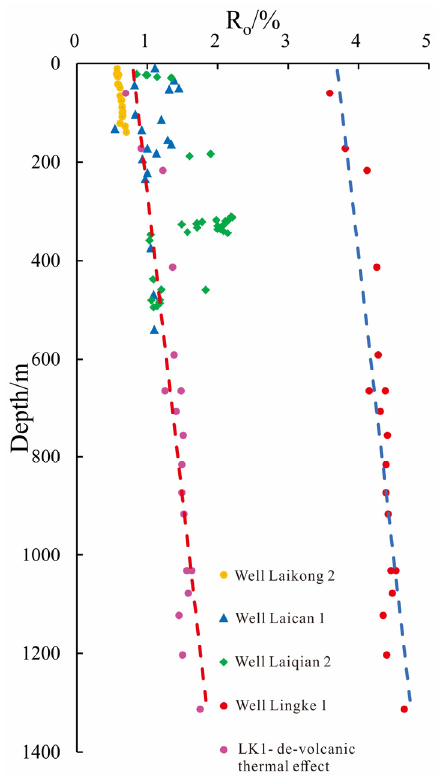
Figure 5. Evolution trend of source rocks in the Laiyang Formation.